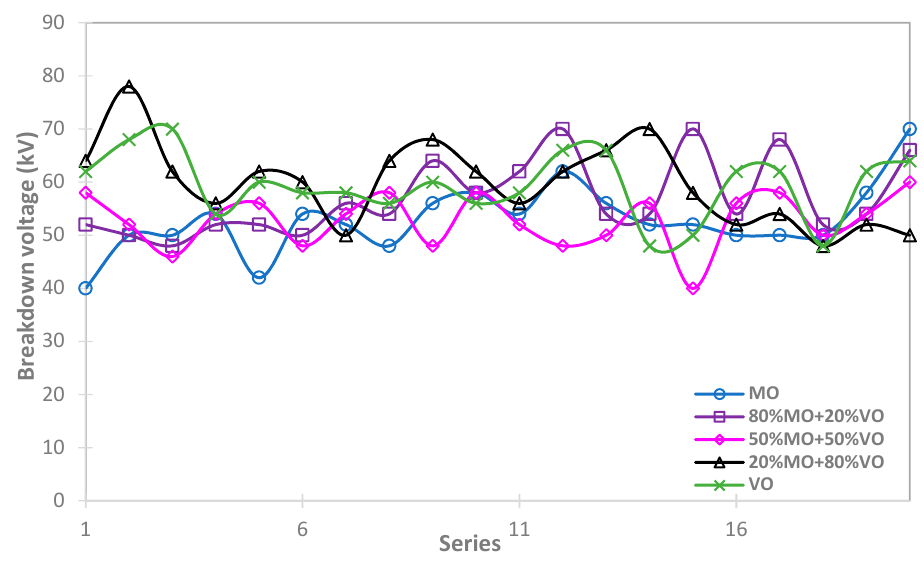
Figure 11. Distribution of breakdown voltages under DC of mineral (MO)/vegetable oil (VO) mixtures.